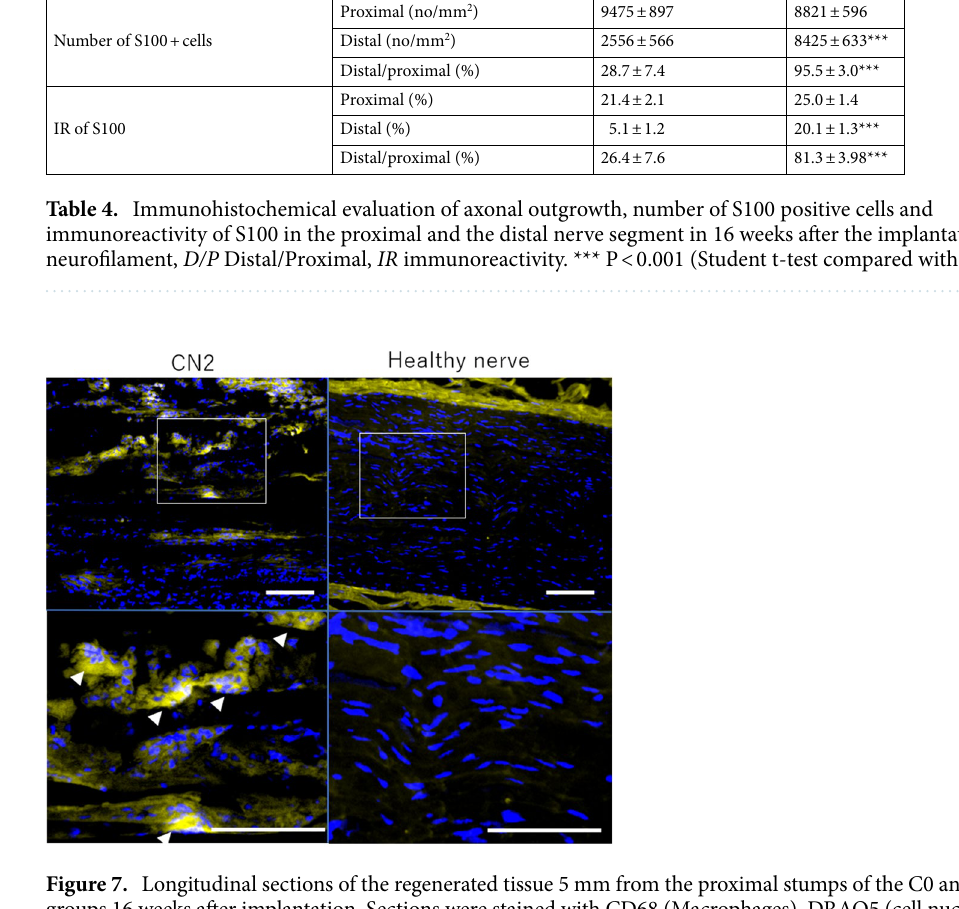
Figure 7. Longitudinal sections of the regenerated tissue 5 mm from the proximal stumps of the C0 and CN2 groups 16 weeks after implantation. Sections were stained with CD68 (Macrophages), DRAQ5 (cell nuclei, blue). Scale bar indicates 100 µm. White arrows indicate CD68 positive multinuclear giant